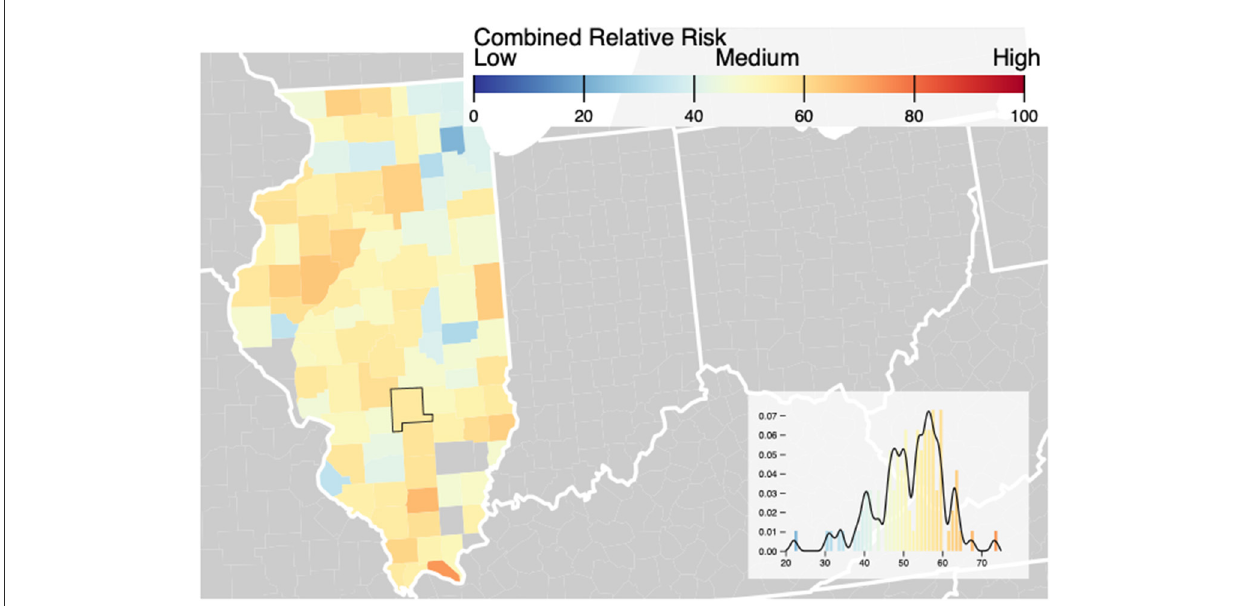
FIGURE11 Map depicting the overall risk that results from combining all factors from Figs. and weighing them according to the business owner’s main concerns. Fayette, IL has a moderate overall risk.